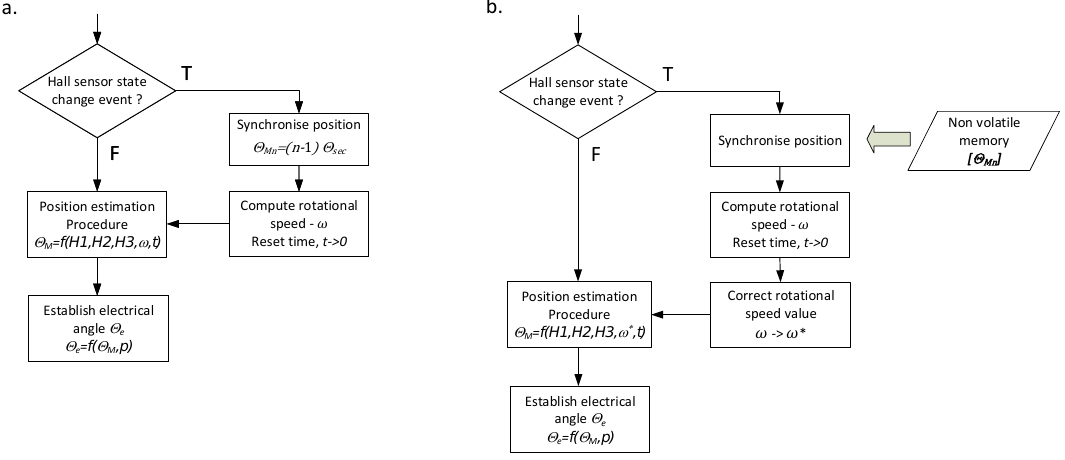
Figure 7. Classic position estimation algorithm based on the analysis of changes in the Hall sensors ’ state ( a ), and the proposed control algorithm ( b ).